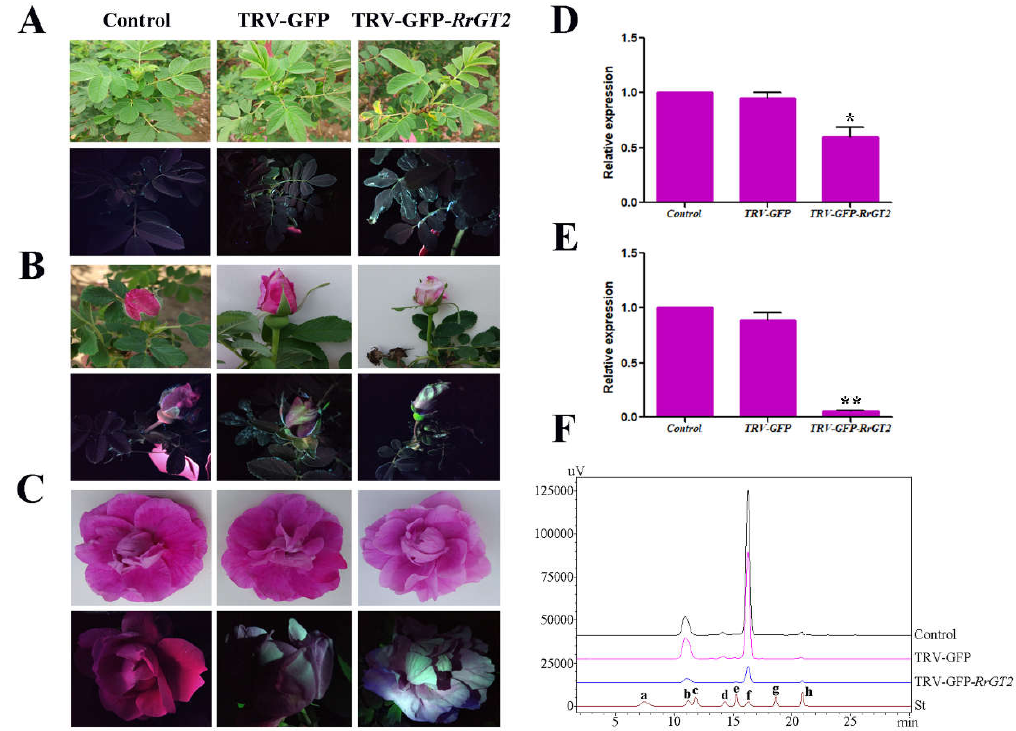
Figure 4. Validation of VIGS in R. rugosa ‘Zizhi.’ Comparisons between the control group and VIGS-treated groups (TRV-GFP and TRV-GFP- RrGT2 ) with respect to leaves ( A ), flowers between budding stage and initial opening stage ( B ) and flowers at the full opening stage ( C ). The plants were imaged under normal light and ultraviolet illumination. qRT-PCR detection of leaves ( D ) and flowers at the full opening stage ( E ) in the control and VIGS-treated groups. RrGAPDH was used as an internal control. The error bars represent the SDs of triplicate reactions. The experiment was repeated three times and each yielded similar results. * and ** indicate a significant difference from the control at p < 0.05 and p < 0.01, respectively, according to Student’s t -test. ( F ) HPLC-derived chromatograms of flowers at the full opening stage. Eight kinds of anthocyanin standards (St) were used for detection: (a) Dp3G5G; (b) Cy3G5G; (c) Dp3G; (d) Pg3G5G; (e) Cy3G; (f) Pn3G5G; (g) Pg3G; and (h) Pn3G.